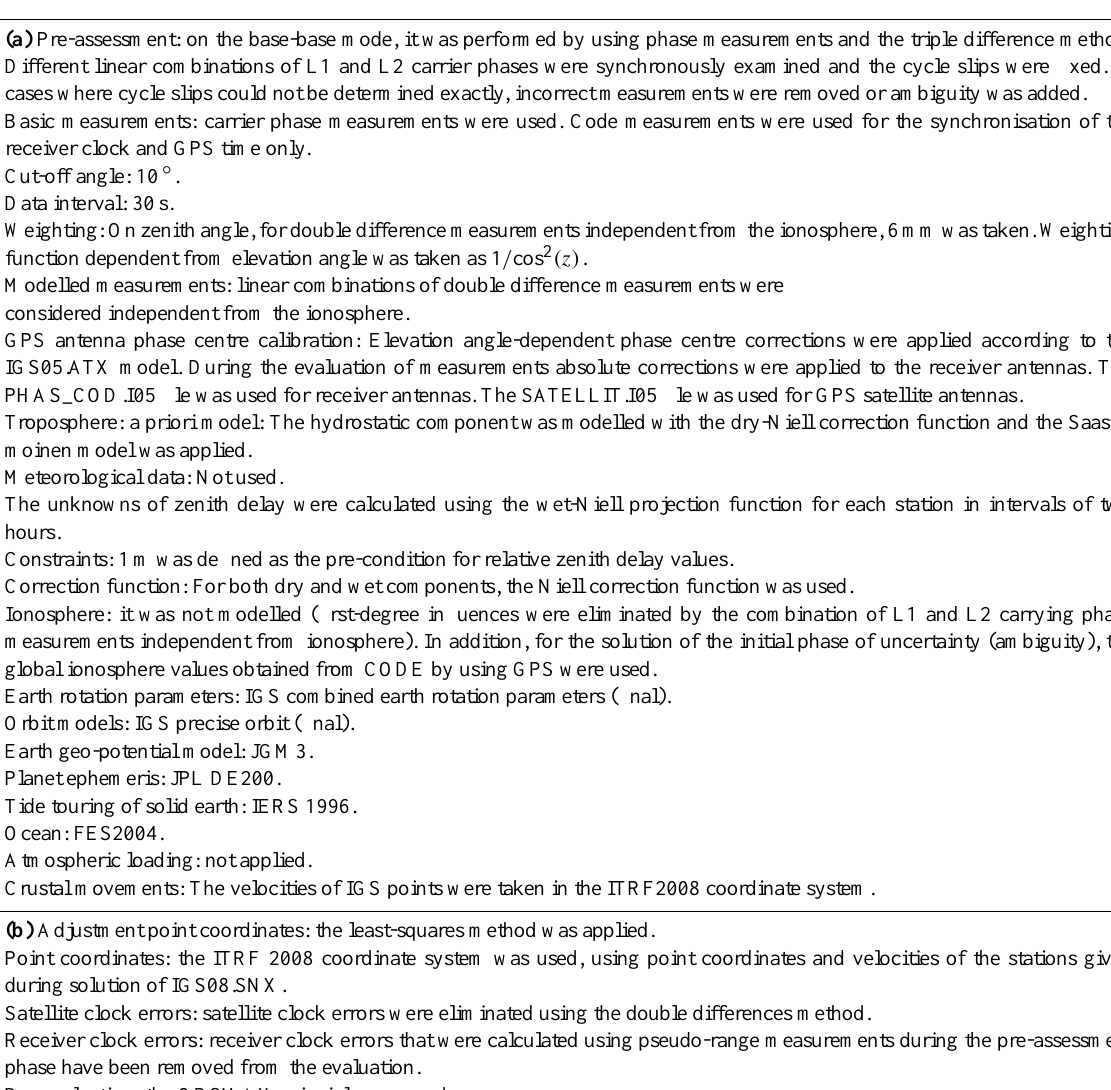
Table 8. Evaluation strategy of GPS measurements with Bernese v5.0 software (a) (model), (b) (parameters). (a) Pre-assessment: on the base-base mode, it was performed by using phase measurements and the triple difference method. Different linear combinations of L1 and L2 carrier phases were synchronously examined and the cycle slips were fixed. In cases where cycle slips could not be determined exactly, incorrect measurements were removed or ambiguity was added.